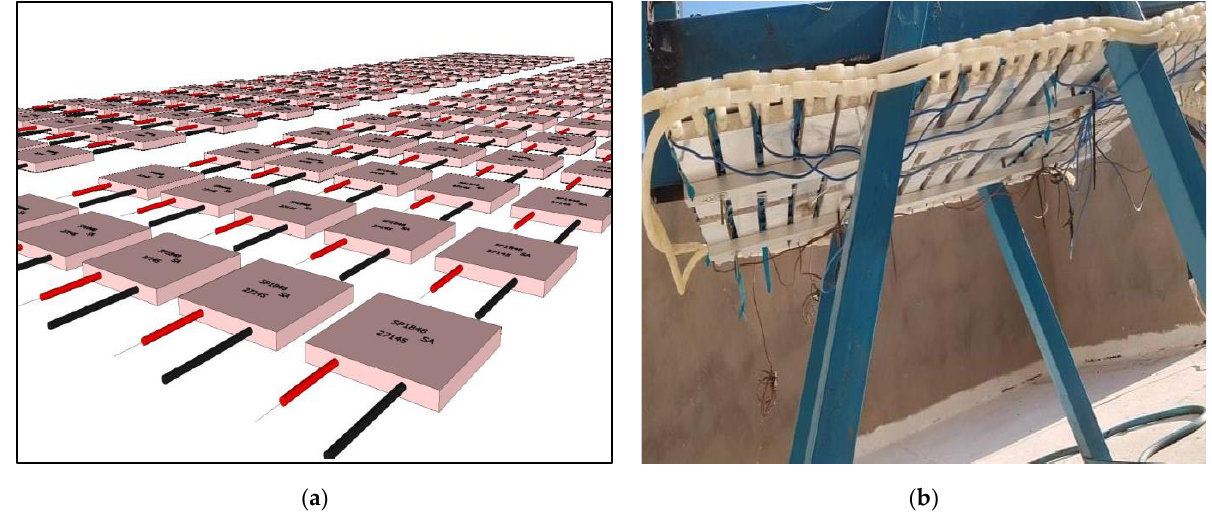
Figure 1. TEG modules ( a ) Connected in series and parallel and ( b ) After integration into the sys- tem.